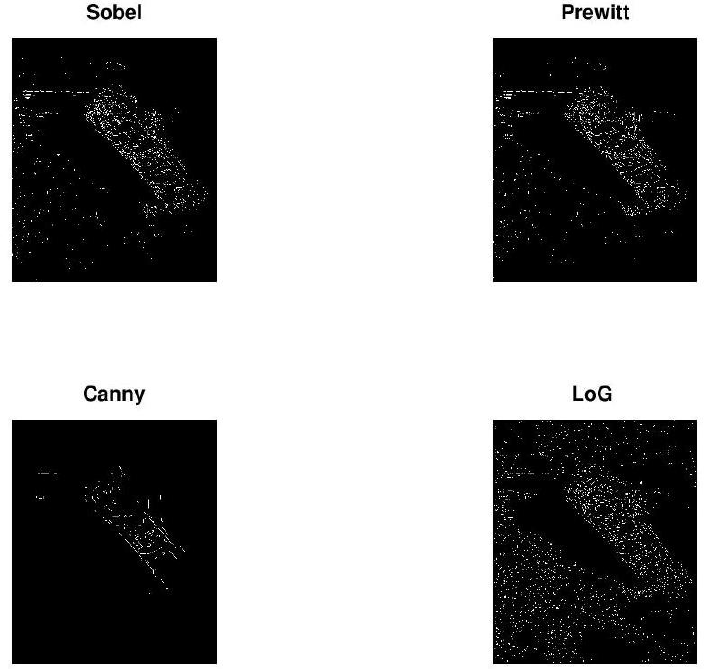
Figure 6. Result of edge detection filters with default